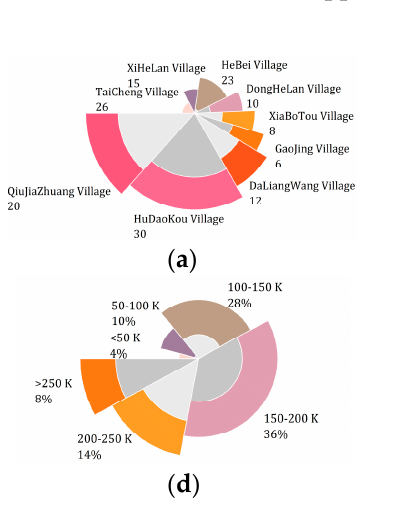
Figure A1. Basic characteristics of field research samples: ( a ) building location; ( b ) construction age; ( c ) floor count; ( d ) total cost; ( e ) user count; ( f ) production mode.